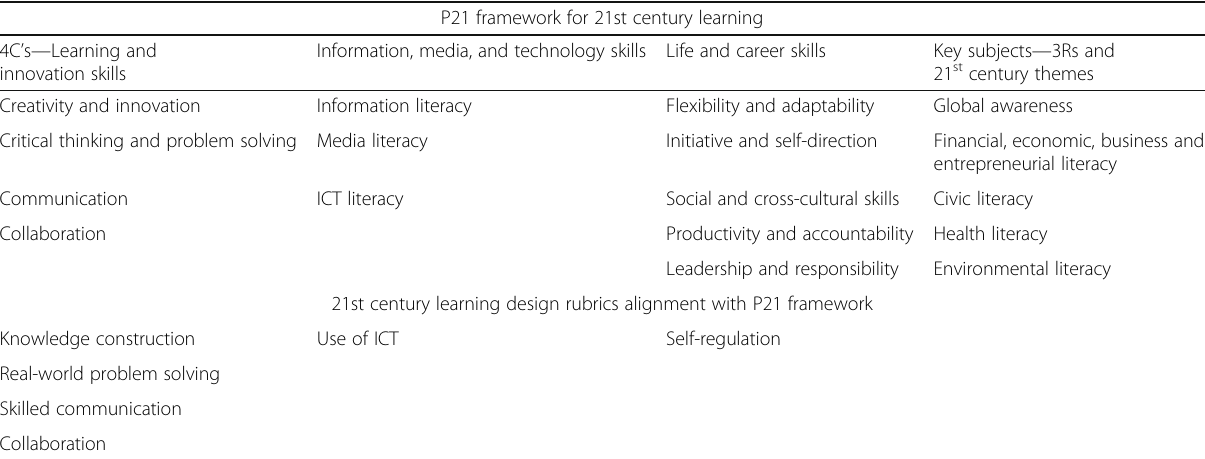
Table 1 The alignment of 21 st century learning components with the 21 st century learning design